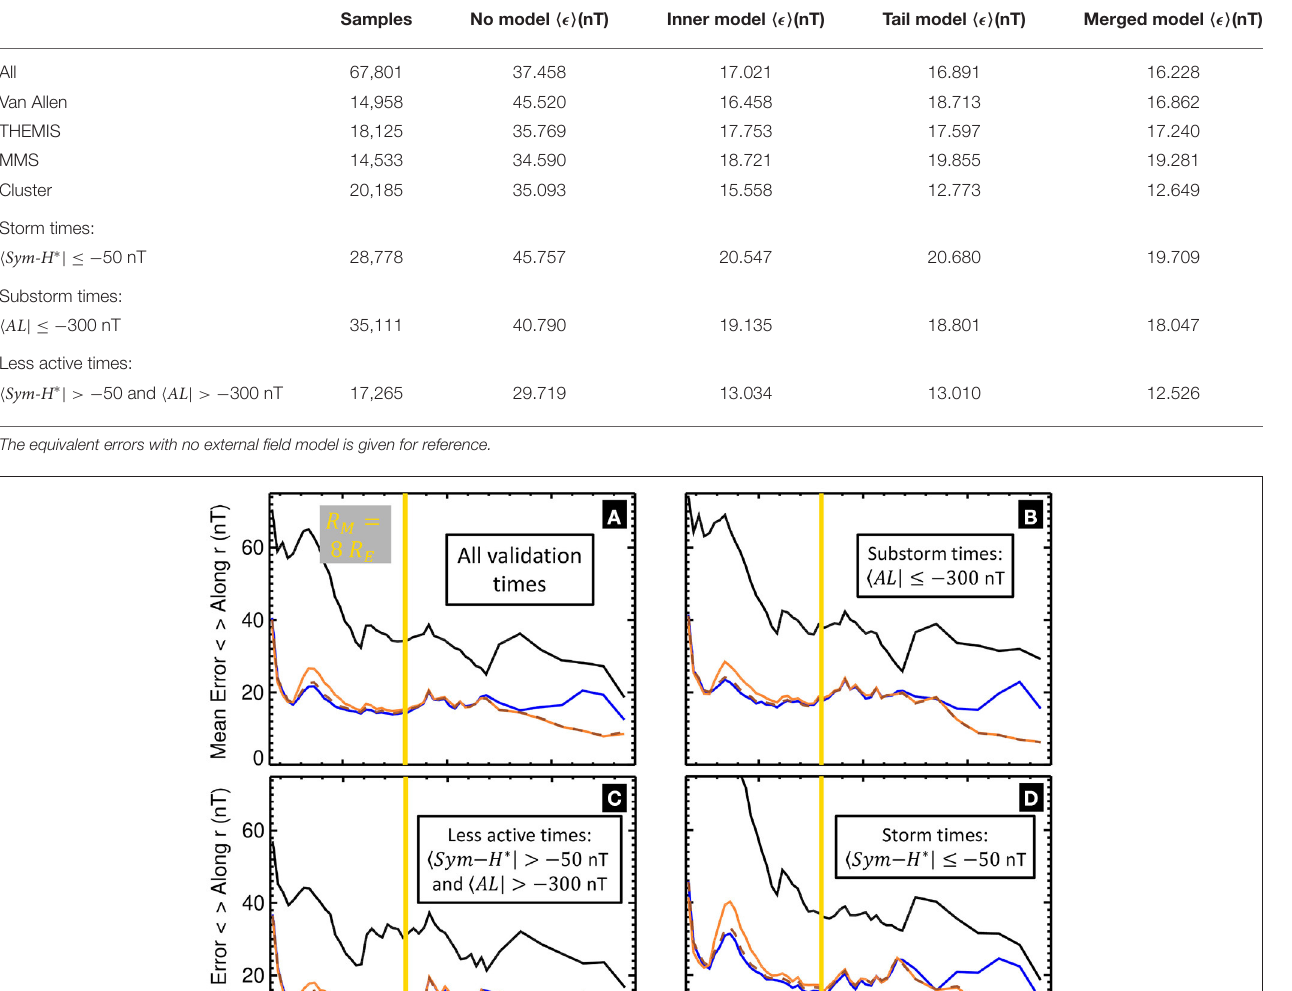
FIGURE 12 | Mean model errors as a function of radius. The mean model errors (orange lines), and Merged Model (dashed brown lines). The errors when no model for B ext is applied is shown for context using the black lines. The errors are further binned into different activity levels: (A) the entire validation set, (B) active substorm times likely during the substorm and storm growth/main and recovery phases, and (D) active storm times